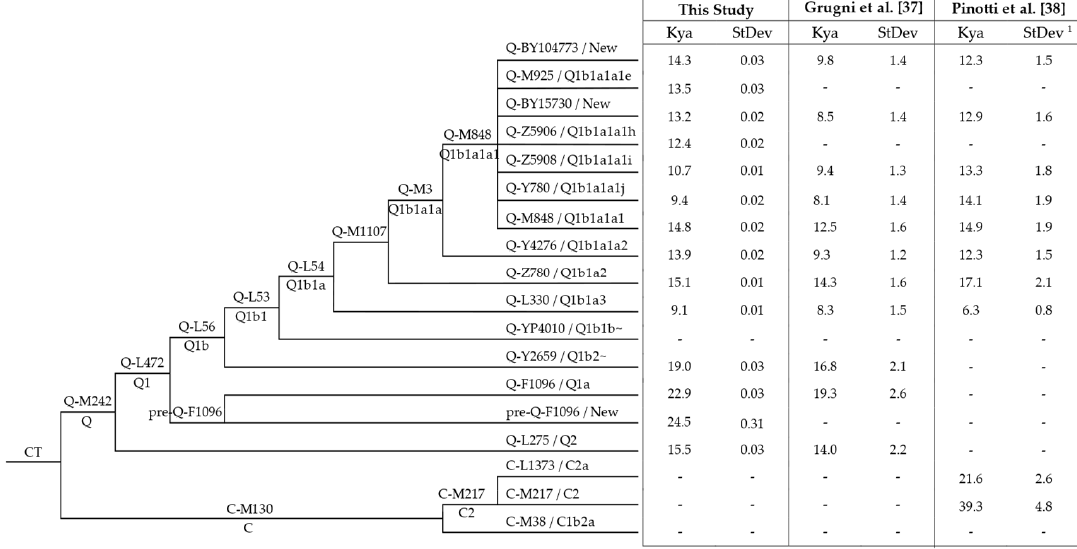
Figure 9. Age estimates of the haplogroup C and Q branches in comparison with those from previous studies (more details in Table S2). ISOGG nomenclature (http://www.isogg.org/tree/, accessed on 19 January 2022) is reported, when available; “New” indicate branches not reported. 1 Standard deviation for the age estimate in Pinotti et al. [38] was calculated from upper and lower bounds. Finally, the effective population size estimates of Q-Z780 and Q-M848 are shown in Figure 10.